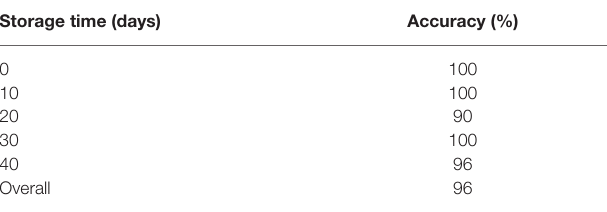
FIGURE 6 | The results of the predicted storage time of the deep learning- based model, which are compared with the actual storage time.